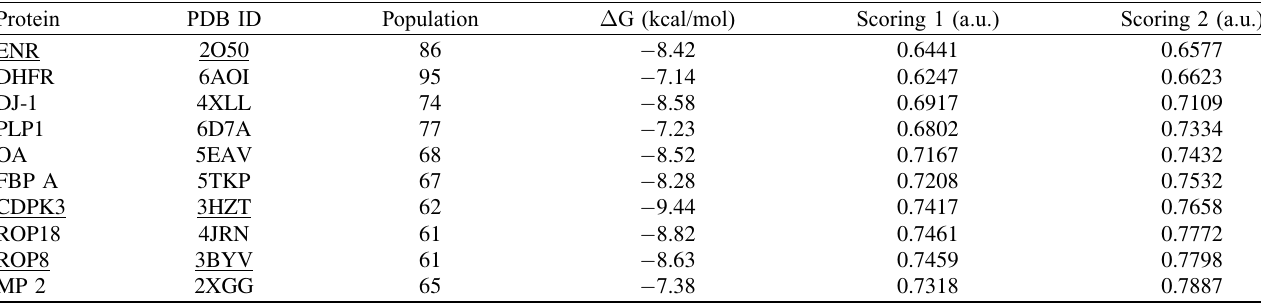
Table 3. Cluster population, free energy of binding, scoring 1 and 2 of the 10 most relevant complexes containing betulone. The three underlined PDB IDs are selected proteins for re-docking experiments.